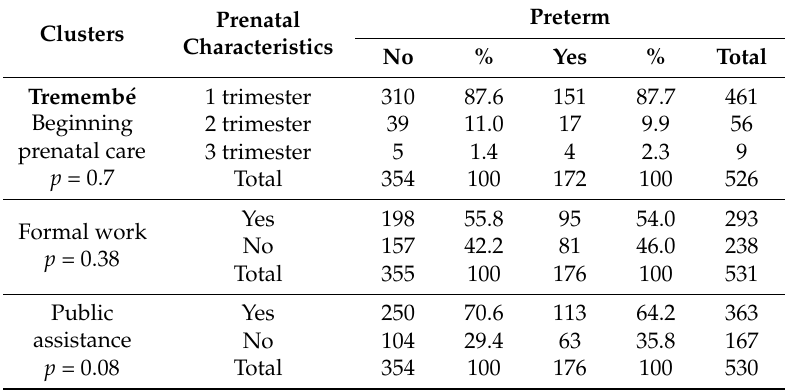
Table 2. Distribution of prenatal characteristics in each cluster. The p values depicted in the first column represent the level of significance of the differences between preterm and term